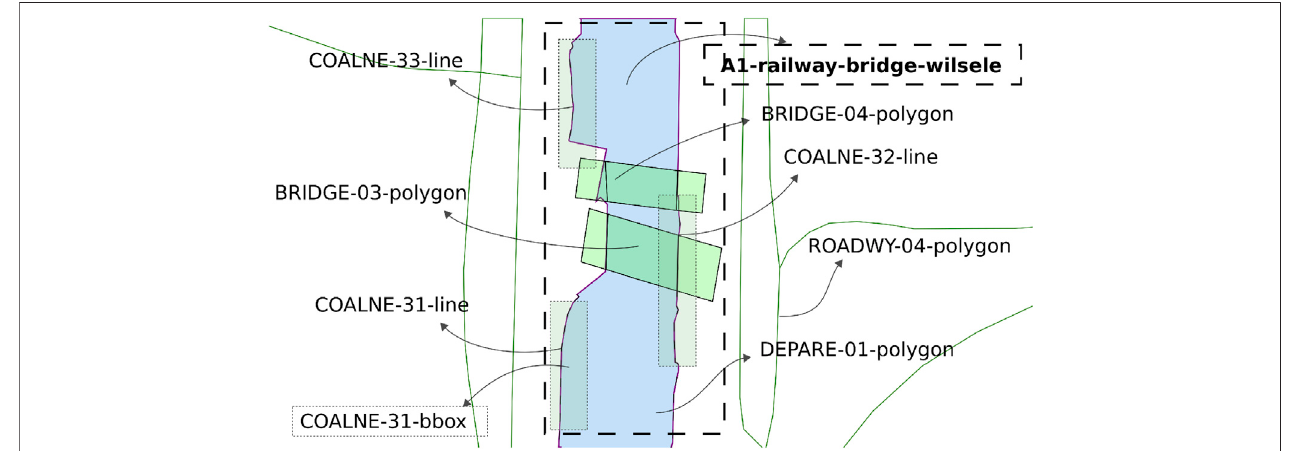
FIGURE 4 | Part of local map from Figure 2B with Symbolic_IDs and additional